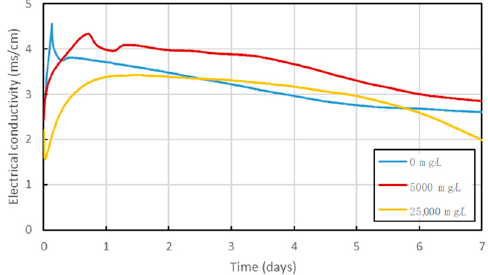
Figure 6. Variation in the electrical conductivity of the specimens with sulfate concentration (CPB made with 0.3% fibers).